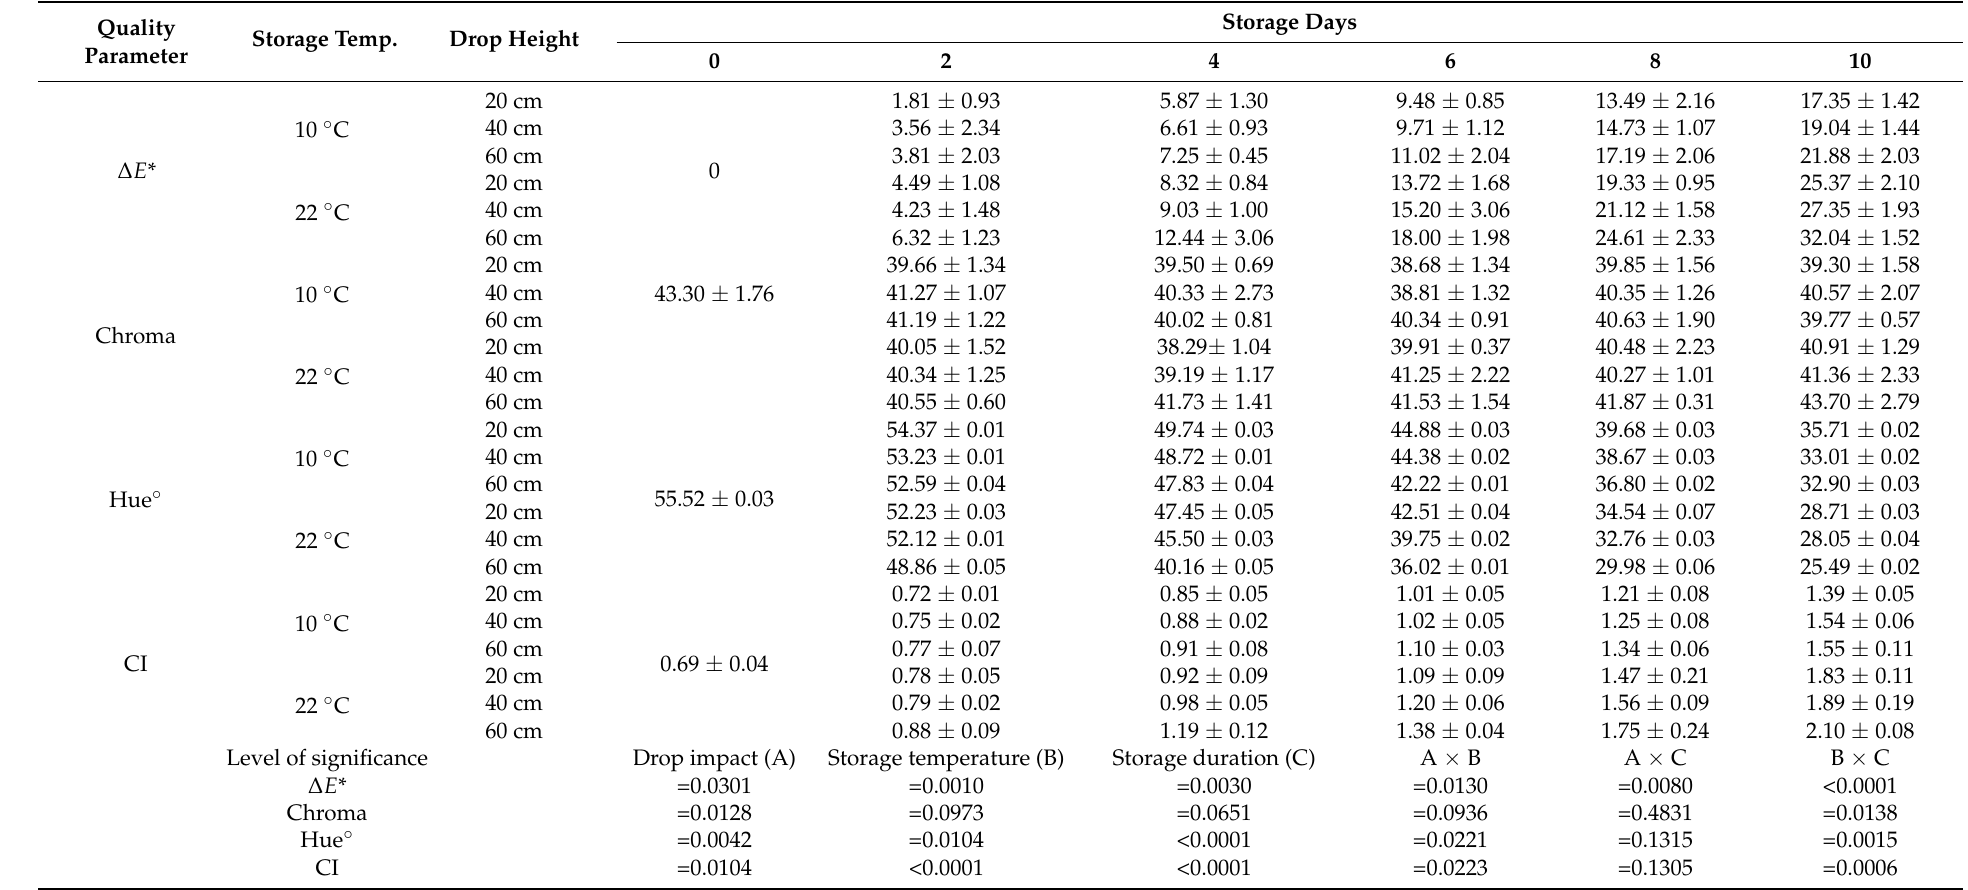
Table 2. The values of total color difference ( ∆ E ), chroma, hue ◦ , and color index (CI) changes of tomato during 10 days at two different temperatures and three drop heights. Error bars represent the standard deviation (SD) of the mean values ± S.D. of 18 readings of three replicates. Quality Storage Parameter